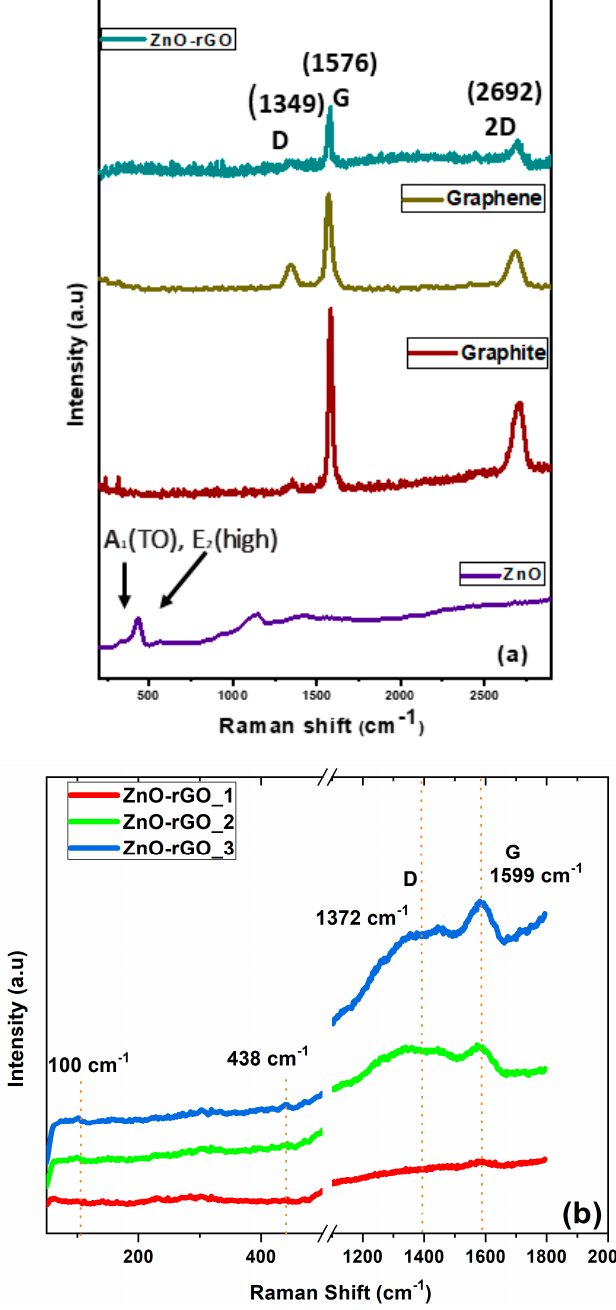
Figure 11. Raman Spectra of ( a ) ZnO, graphite, graphene and ZnO-rGO in powder, and ( b ) ZnO-rGO thin films. thin